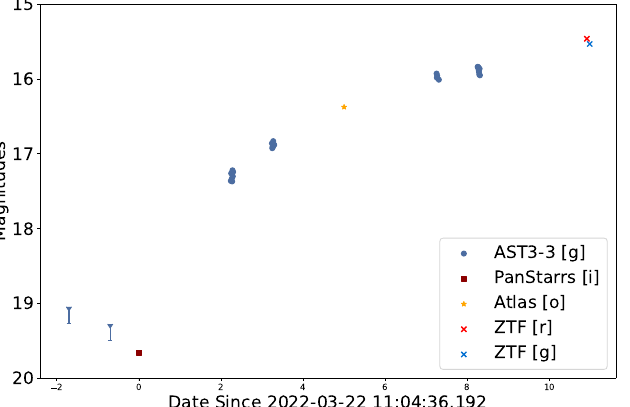
Figure 11. The light curve for SN 2022eyw combines photometry data from Pan-Starrs, ATLAS and ZTF. AST3-3 observation gives the magnitude limit before the report from Pan-Starrs. The filter o for ATLAS is orange-ATLAS. All the TNS data is taken from TNS Website. https://www.wis-tns.org/ object/2022eyw (accessed on 19 May 2022).